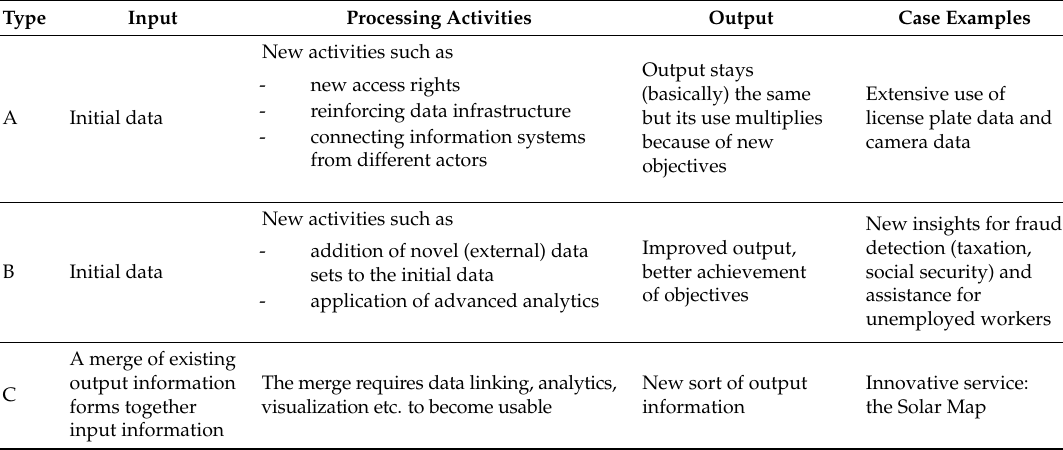
Table 1. Overview typology evolutions in the traditional government information